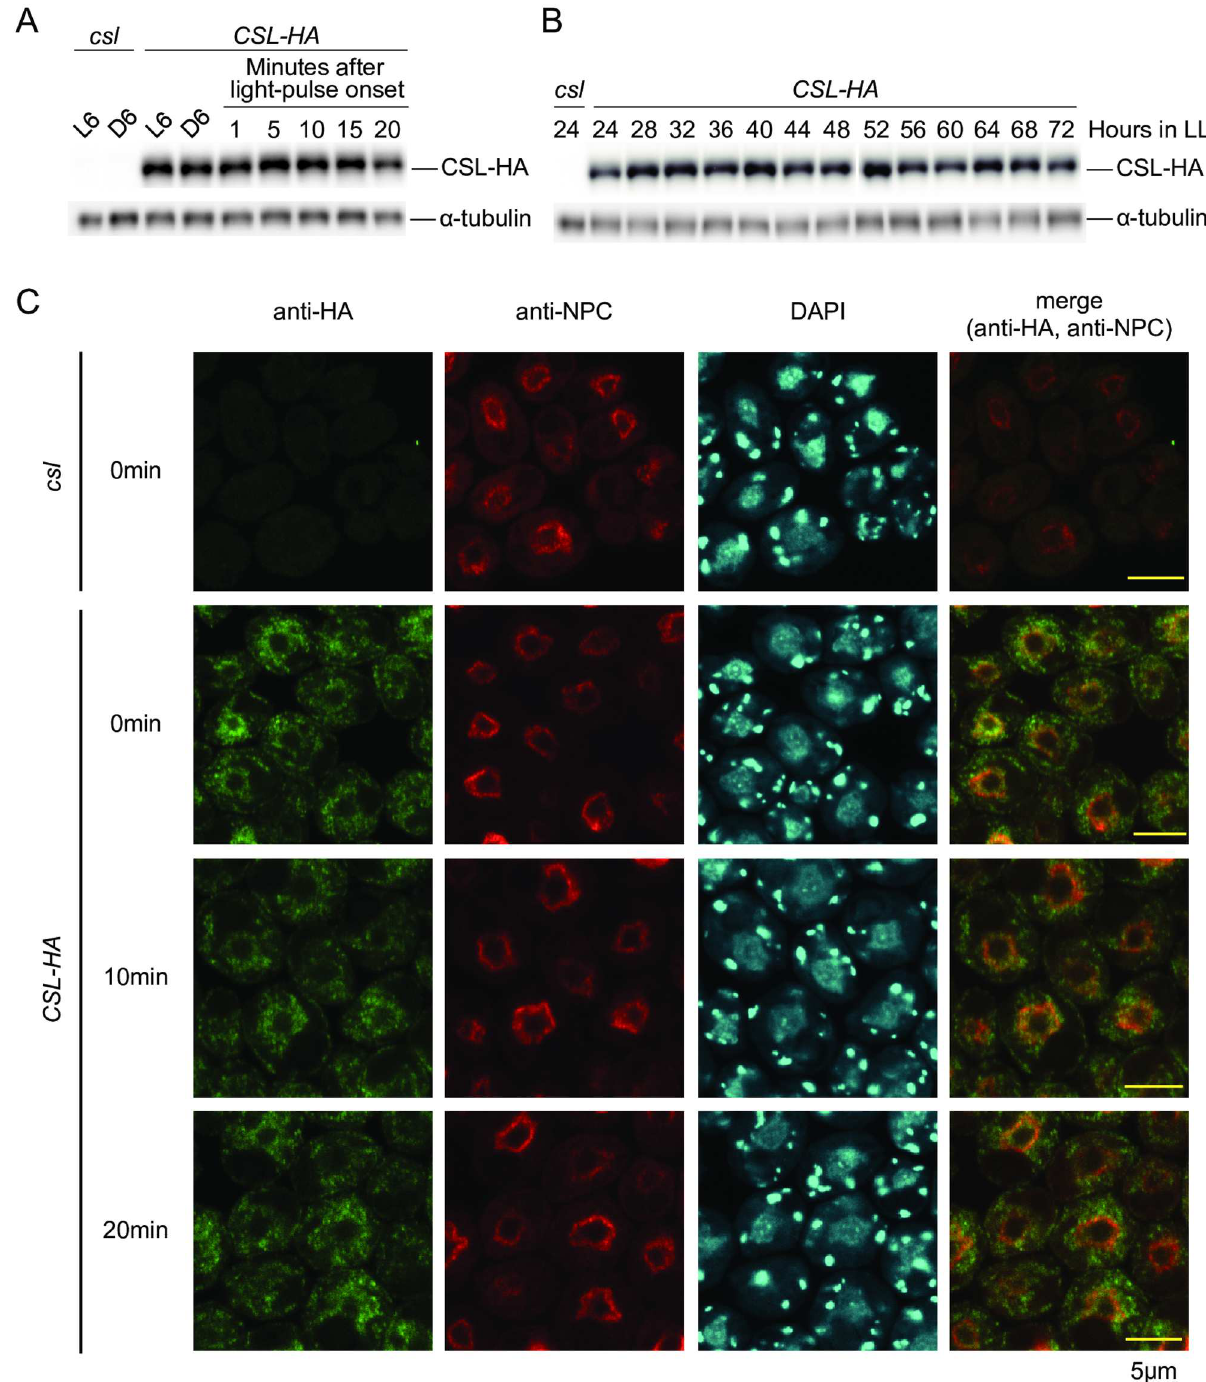
Fig 8. Expression analysis of CSL protein. (A) Western blot analysisof CSL-HA in LD and after light pulse. Cell were harvestedfrom LD- entrainedHS liquidcultures at midday and midnight. A red light pulse (2 μ mol (cid:1) m -2 (cid:1) s -1 , 0.5 min) was given at midnight,and cells were harvestedat times indicatedin the graph. 2 μ g of total protein was loadedin each lane. (B) Western blot analysisof CSL-HA in a circadian condition.Mid-log-phase (approximately 2 x 10 6 cells/mL) HS liquidcultures at 24˚C were transferred to 12 h darknessat 17˚C to synchronizethe circadianclock, and then released into a continuous light condition(2 μ mol (cid:1) m -2 (cid:1) s -1 , white light, 17˚C). 10 μ g of total protein was loadedin each lane. Western blots for α -tubulinare shown as a reference protein (A,B). (C) Immunocytochemical staining of CSL-HA. Cells preparedas describedin (A) were used. Cells were counterstained with NPC antibodyand 4 0 ,6-diamidino-2-phenylindole(DAPI). Photographs obtained under the same settings of microscopeand detector are shown. csl mutant was used as negativecontrols